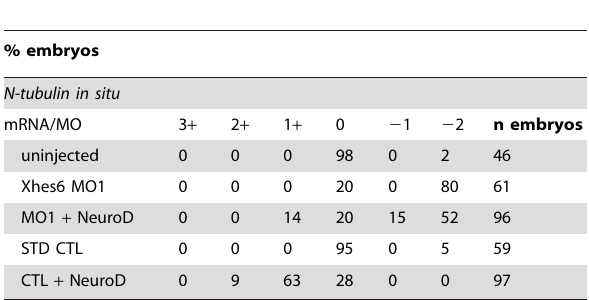
Table 3. Activity of NeuroD in Xhes6 morphant